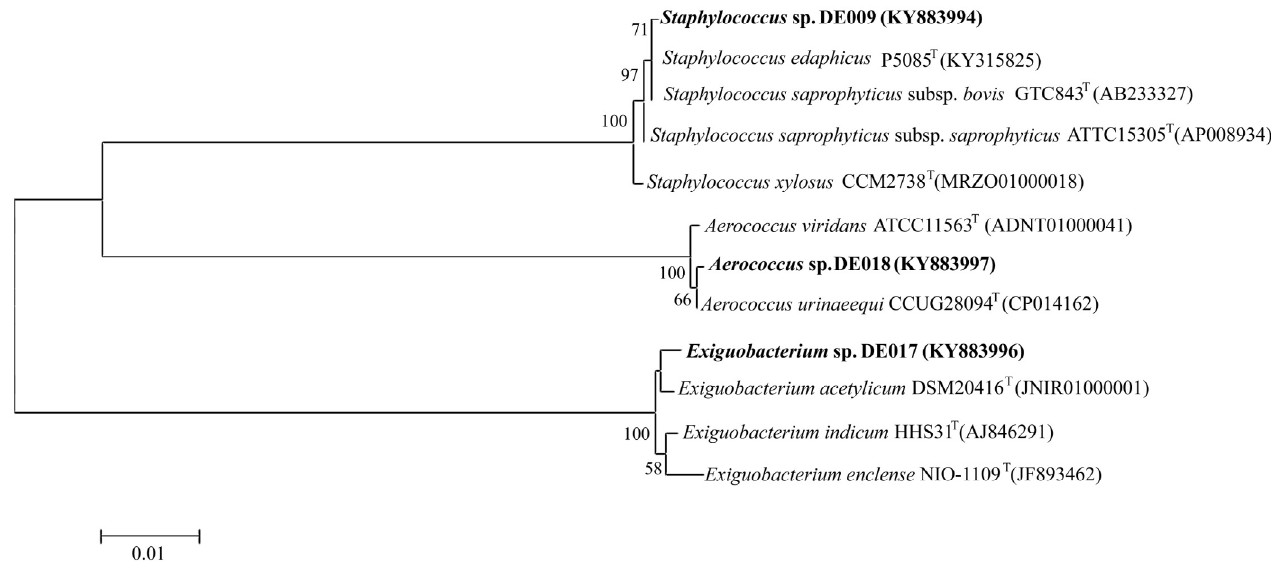
Fig 3. Neighbor-joining tree reconstructed based on 16S rDNA gene sequences showing the phylogenetic relationship between non- Bacillus Gram-positive isolates and closely related type strains. Bootstrap values (500 replication) >50% are given at nodes. Table 3. Comparisons of the isolatesand closely related type strains. Characteristics are scored as: -, negative reaction; +, positive reaction; nd, not